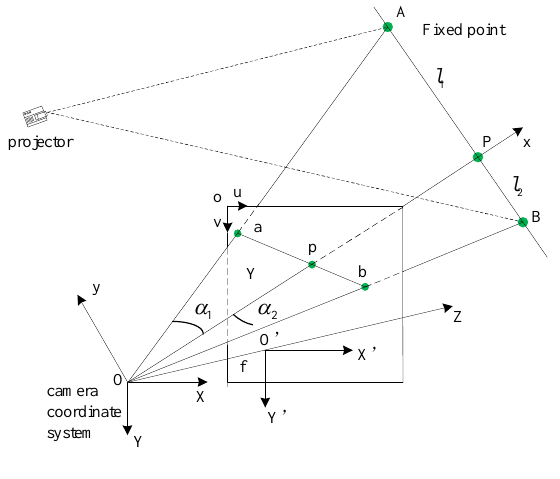
Fig. 2. Linear structured light sensing system calibration